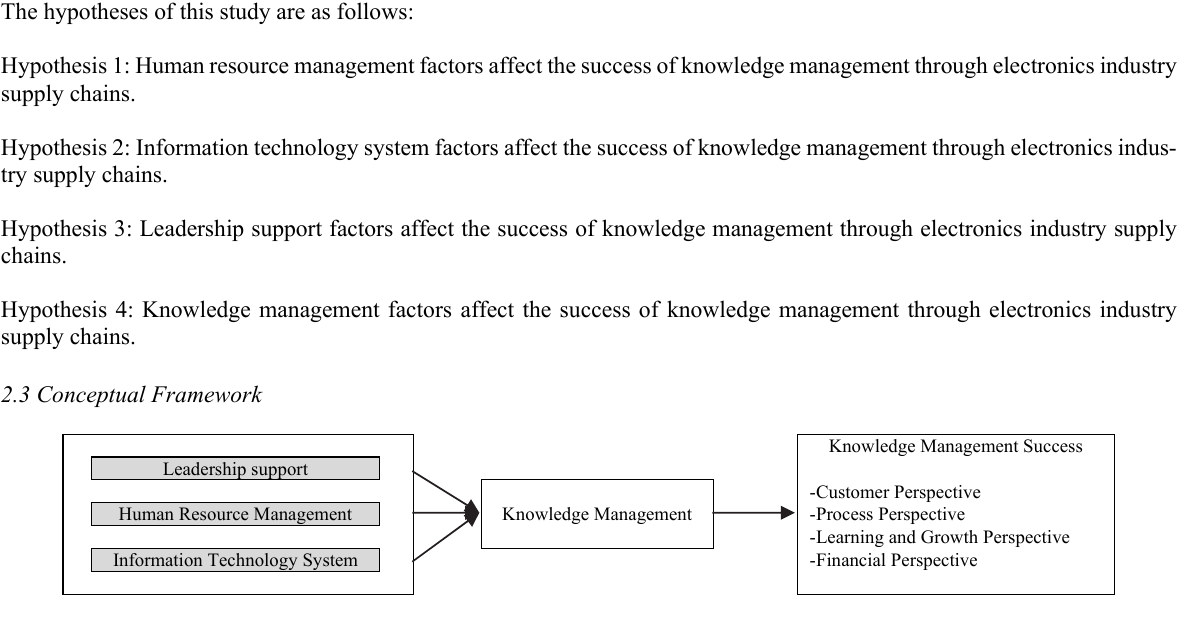
Fig. 1. Conceptual Framework for a Success Factors for Knowledge Management